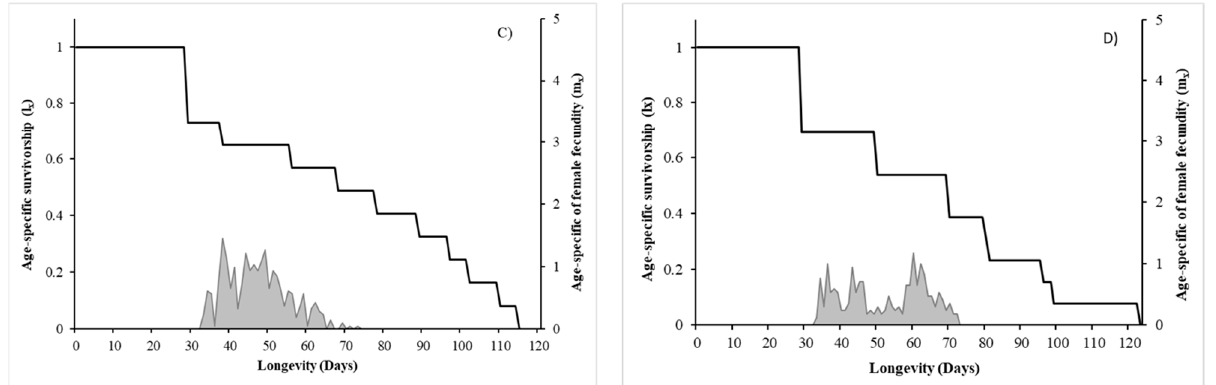
Figure 1. Age-specific survivorship ( l x ) and age-specific of female fecundity (m x ) curves of Macrolophus pygmaeus from the Azores fed on E. kuehniella ( A ) or T. absoluta ( B ), and from mainland fed on Ephestia kuehniella ( C ) or fed on Tuta absoluta ( D ). (25 ± 1 °C; 75 ± 5% relative humidity and light regime 16L:8D).